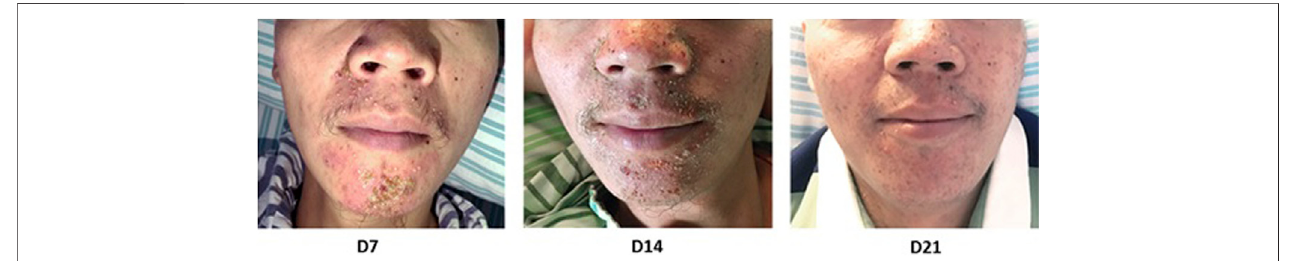
Frontiers in Pharmacology |